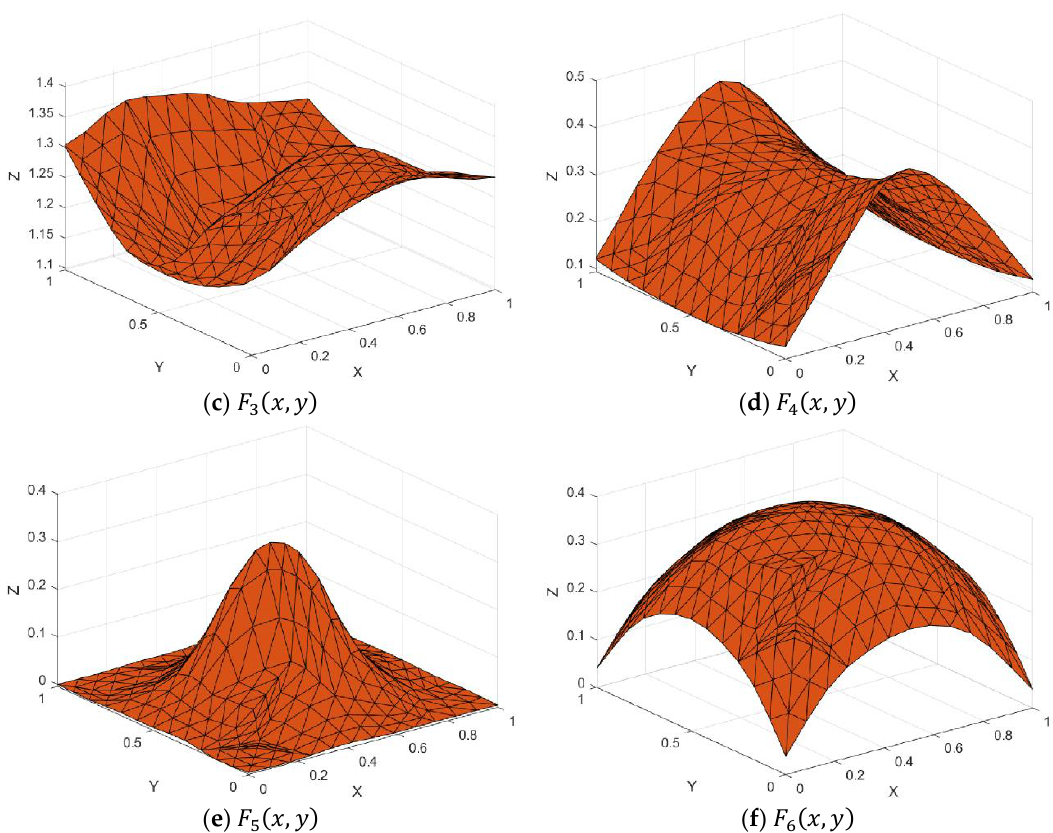
Figure 15. Surface interpolation using Foley and Opitz method and Choice 2 for 36 datasets.